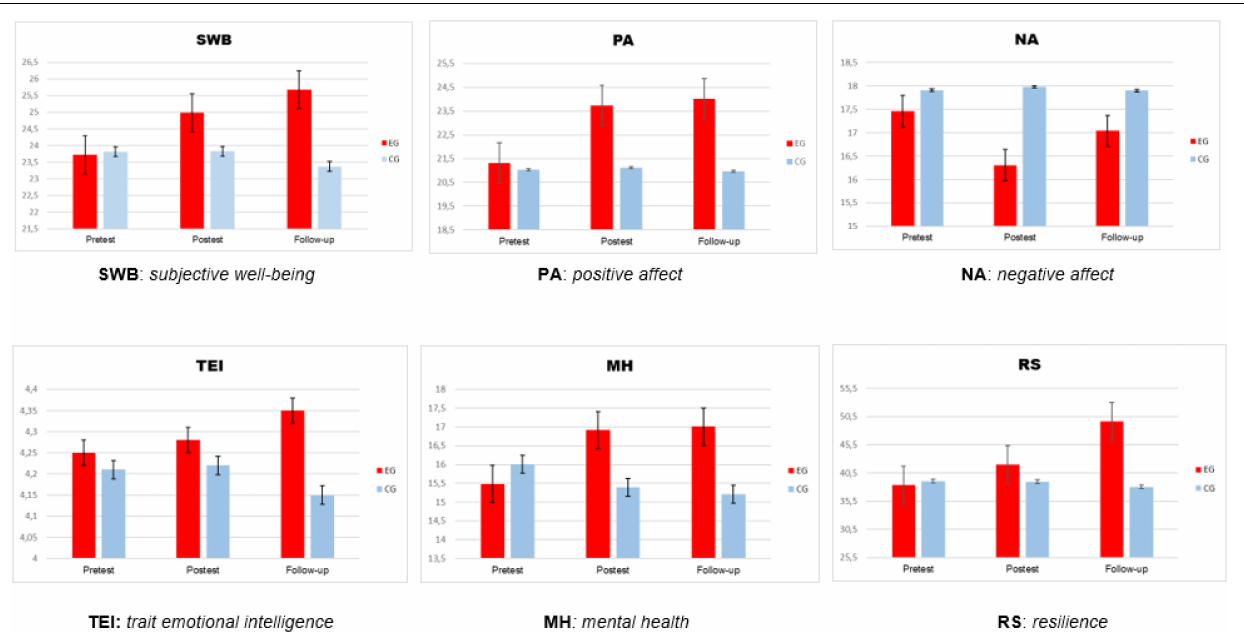
FIGURE 2 | Effects of MBI on the variables of the study across three times (pretest, before training; post-test, after training; follow-up, 6 months after training).